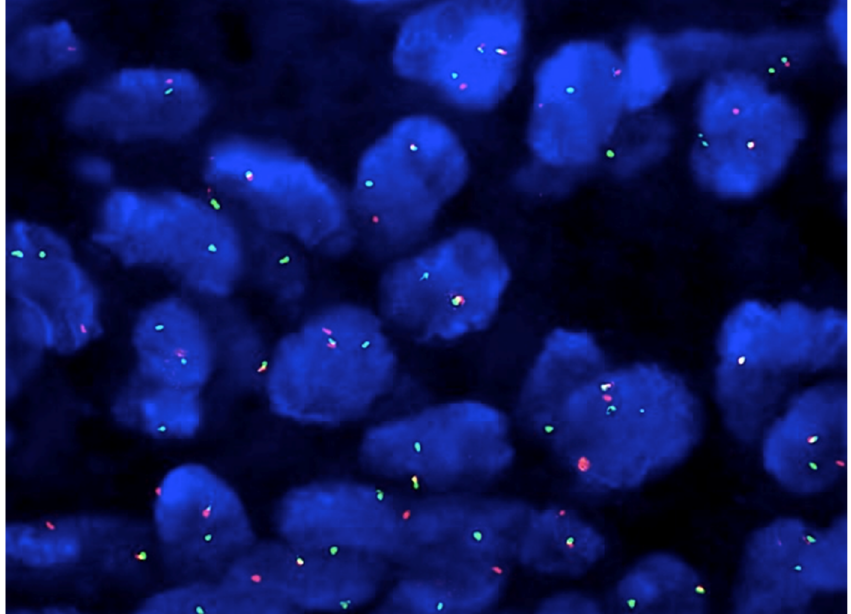
Figure 4. Molecular study using fluorescence in situ hybridization (FISH) break apart probe confirmed a diagnosis of synovial sarcoma detecting the SS18 gene arrangement (split red and green signal) (×200).